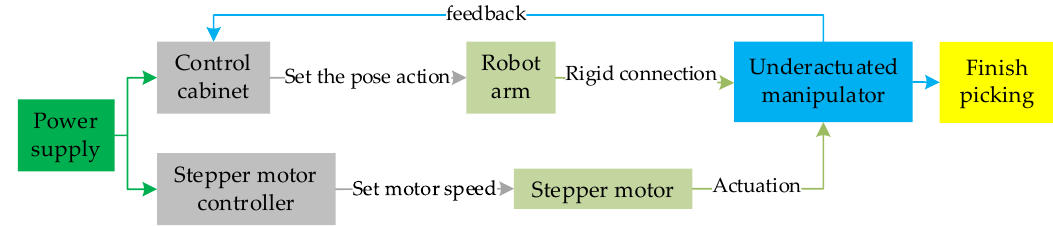
Figure 12. Diagram of the broccoli-picking test stand system.